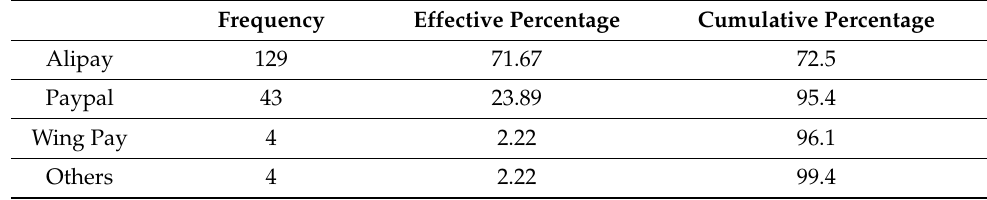
Table 2. Usage of the user payment platforms.